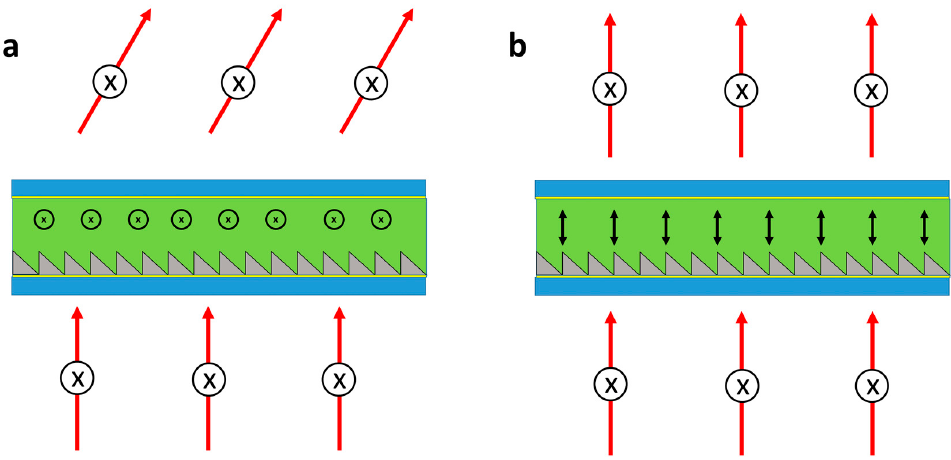
Figure 10. ( a , b ) Diagram of the beam deflector device presented by Wang et al., in 2000 [134]. Here, the refractive index of PMMA is approximately equal to n ⏊ of the NLC, meaning minimal diffraction occurs in the on state.